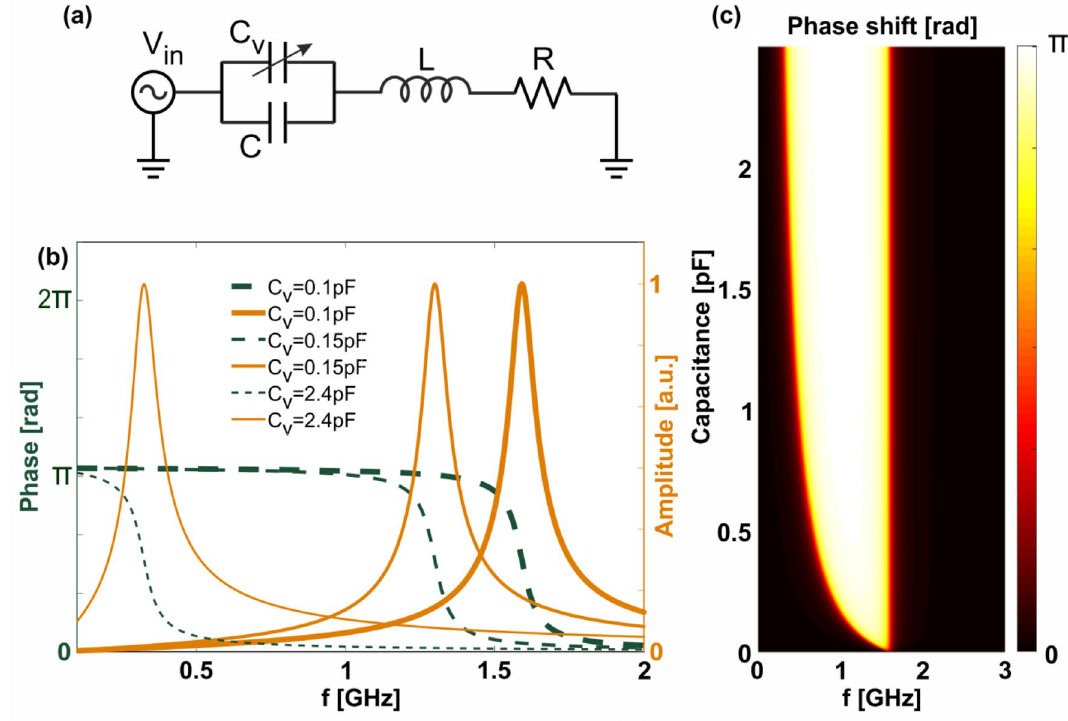
Figure 2. Controlling the scattered phase from a dipole using a varactor. ( a ) The equivalent circuit of the scattering scenario—a dipole is represented by internal inductance, Ohmic + radiation resistance R , capacitance C and an additional varactor capacitor C v , which is introduced within the structure. ( b ) Resonance control— tuning the bias voltage drop on the varactor serves to shift the resonance of the dipole, which affects the amplitude and phase of the scattered field. Orange lines—unity normalized amplitudes of the current on the wire, green dashed lines—corresponding phases. Nominals of the varactor are given in the legends. ( c ) Color map of the achievable phase shift of the scattered field as a function of varactor capacitance and incident wave linear in frequency. The dipole is excited by an incident radiation, which is partially reflected back into the source (e.g. a radar antenna). If the resonant frequency of the dipole it temporally modulated, the scattered field acquires an additional time-dependent phase shift. Note that radar systems almost never rely on the amplitude of scattered echoes for detection, mainly due to its unpredictability in real environments and unidentified tar- gets. Temporal modulation of the dipole is realized by incorporating a voltage-controlled capacitor (varactor) within the structure. Figure 2a demonstrates a lumped elements scheme for the scattering scenario containing the dipole and varactor. Here the impinging wave is represented by the voltage source V in , while the resistance R , capacitance C , and inductance L characterize the dipole and depend on the material composition and geo- metric shape of the resonator. Placing a voltage dependant varactor in the feeding gap of the dipole can serve